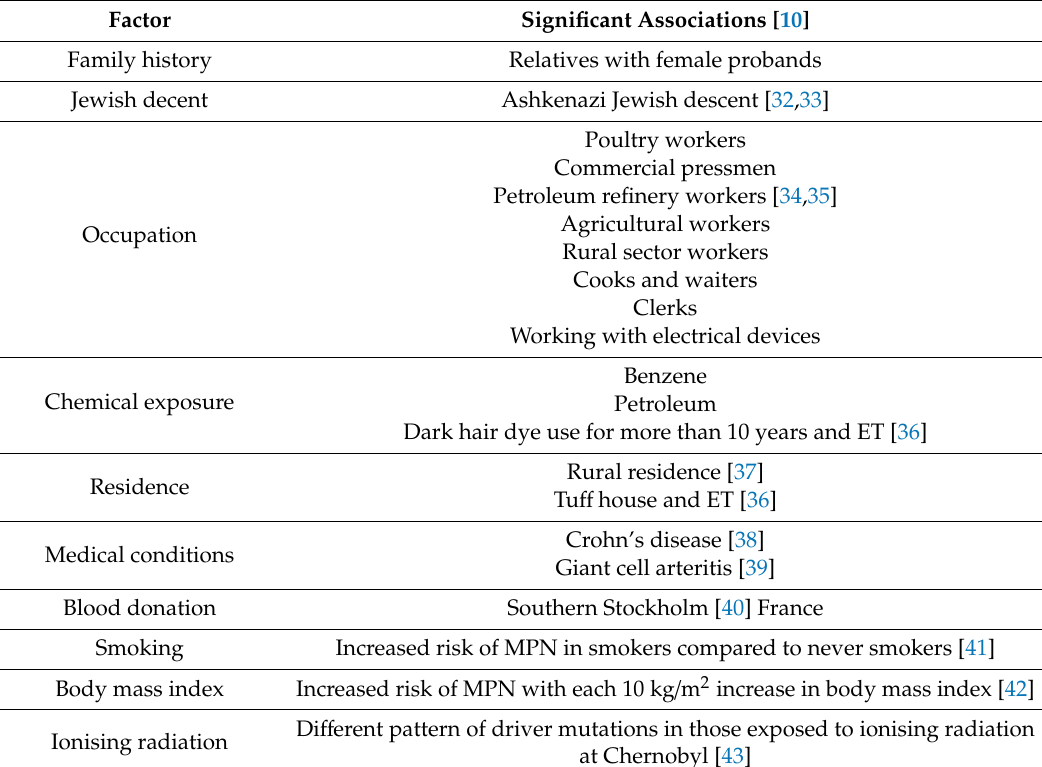
Table 2. Environmental, lifestyle, and familial / ethic factors associated with myeloproliferative